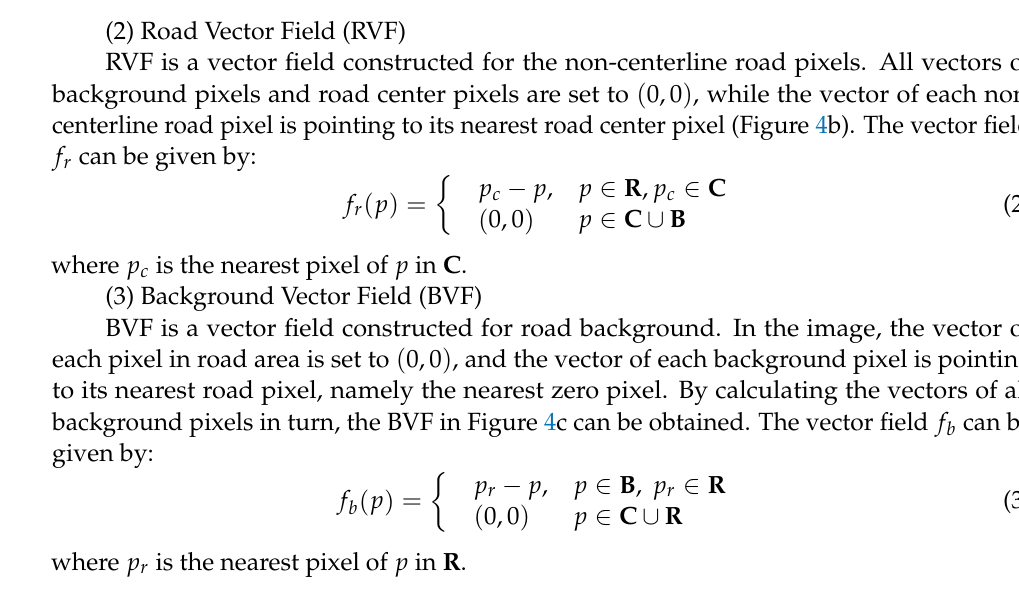
Figure 4. Three Vector Fields for Road Extraction: ( a ) CVF, ( b ) RVF and ( c ) BVF. The long red arrows indicate the axes of image coordinate systems, the long yellow arrows indicate the image coordinates of any pixels in the image, and the short red arrows indicate the unit vectors in the fields.